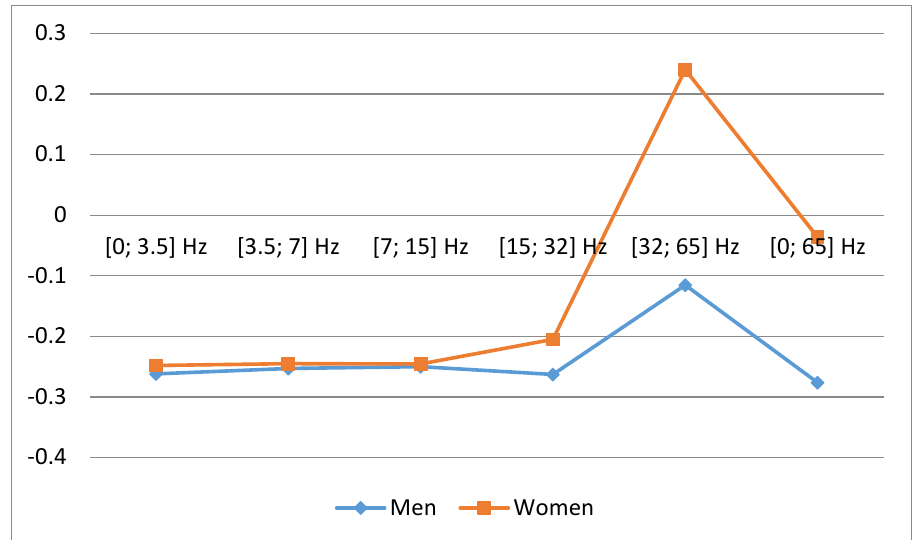
Figure 9. Correlation coefficients between number of men and women weekly cases of MI and mean magnetic power in different frequencies for older (>63 years) men group and women group for all year 2016. Difference between genders is non-significant.